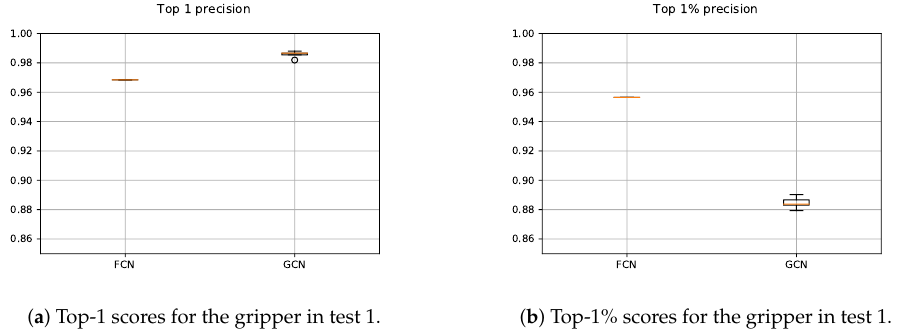
Figure 13. Obtained precision scores per confidence percentiles for the gripper models in Test 1.